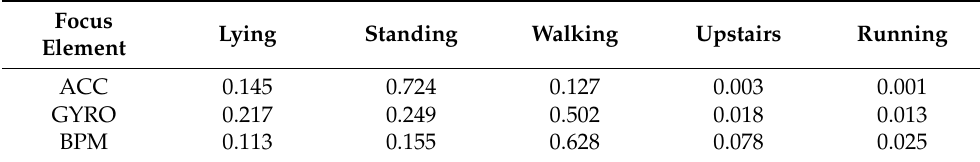
Table 4. BPA for each behavior